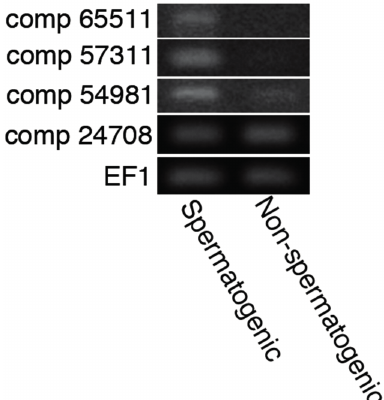
Figure 6. Expressions of the genes with contig DNA sequences in spermatogenic or non-spermatogenic testes. RT-PCR was performed using 1 µg of total RNA purified from spermatogenic or non-spermatogenic testes. Details are in Experimental section.